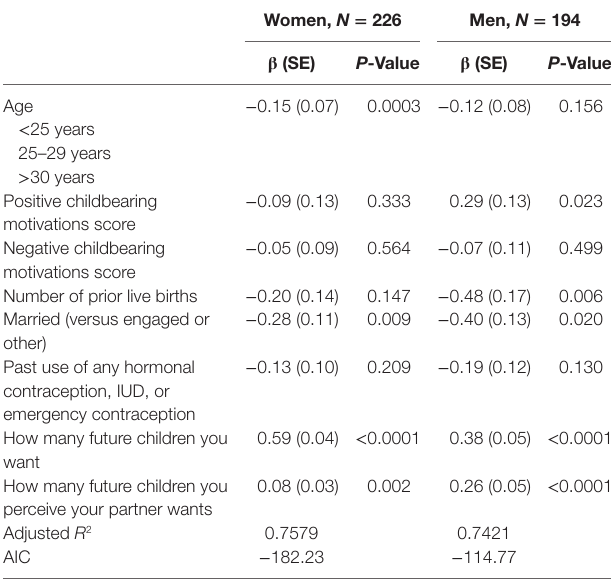
TaBle 7 | Factors associated with number of children intended in the future in women and